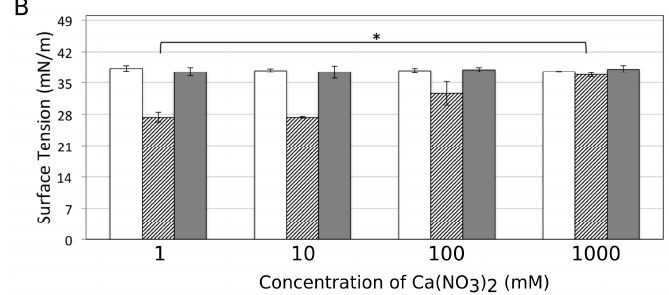
Figure 5. Surface tension measurement of the 2×SG medium and the supernatants of various B. subtilis mutants in the presence of different Ca 2+ levels. ( A ) Surface tension of the 2×SG medium (white bar), wild type, Δ srfAA , and Δ epsA-O mutant supernatants (black striped bars). ( B ) Surface tension of the 2×SG medium (white bars), the supernatants of WT (striped bars), and of Δ srfAA (filled bars) strains in the presence of different Ca 2+ concentrations. The error bars indicate 95% confidence intervals. Data was analysed with paired t-test for significantly different samples (* = p < 0.05).